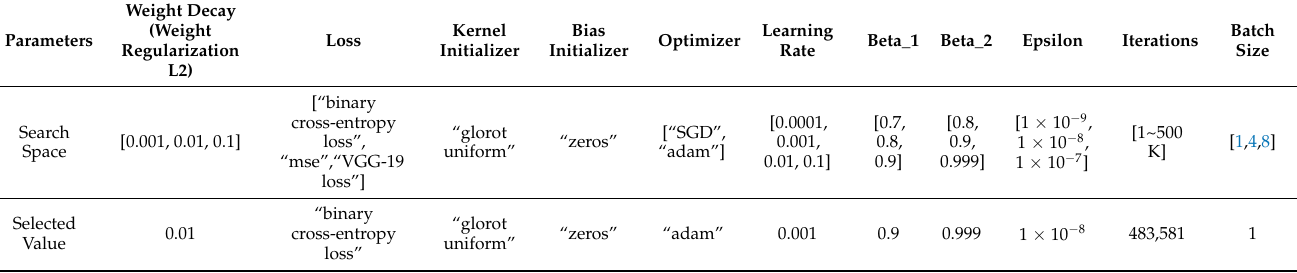
Table 11. Search space and selected values of